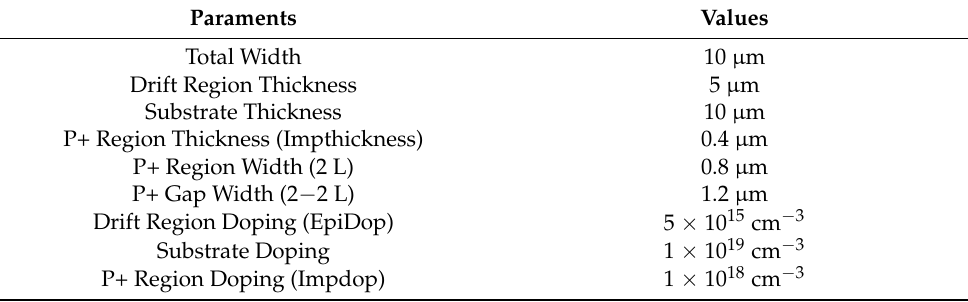
Table 1. GaN JBS device structure parameters.